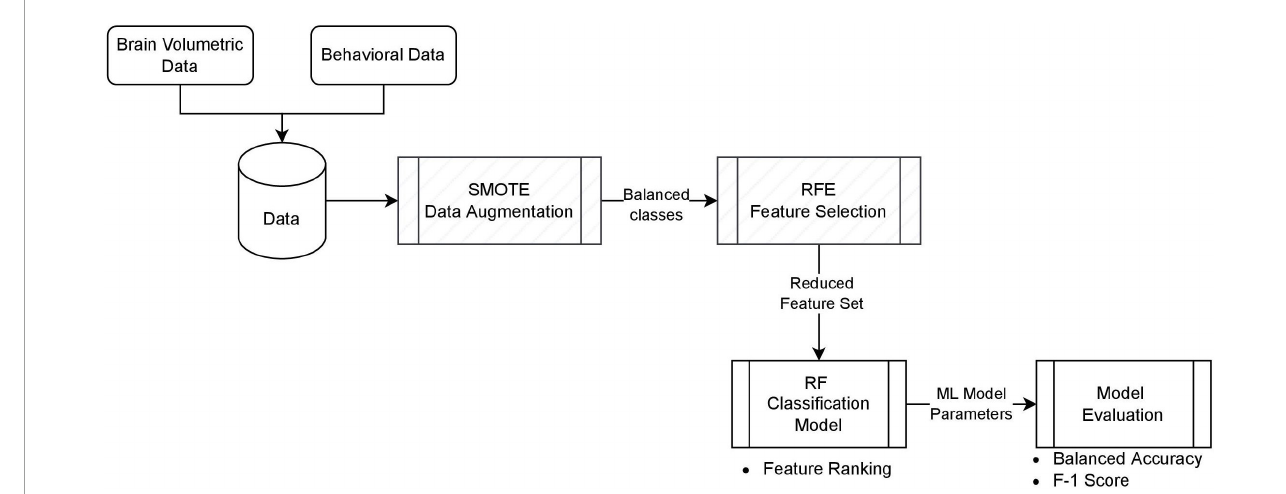
FIGURE1 The classification model. Each block represents the implementation component, and the bullet of items is the outcome of that block. Hatch blocks are optional, depending on the model setting.